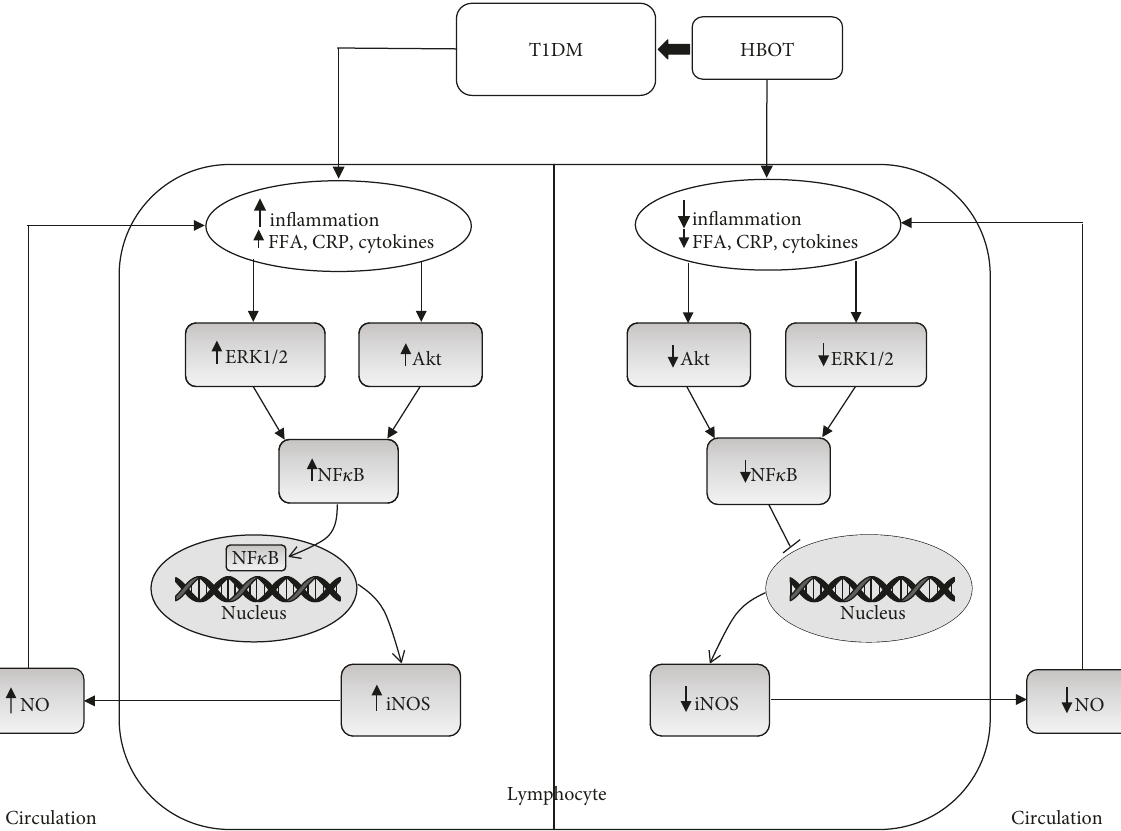
Figure 6: The proposed mechanism by which HBOT a ff ects regulation of iNOS activity/expression and nitrite/nitrate production in T1DM patients. iNOS: inducible nitric oxide synthase; NF κ B-p65: the p65 subunit of nuclear factor- κ B; NO: nitric oxide; ERK1/2: extracellular signal-regulated kinases 1 and 2; Akt: protein kinase B; CRP: C-reactive protein; FFA: free fatty acid. Other abbreviations are under Table